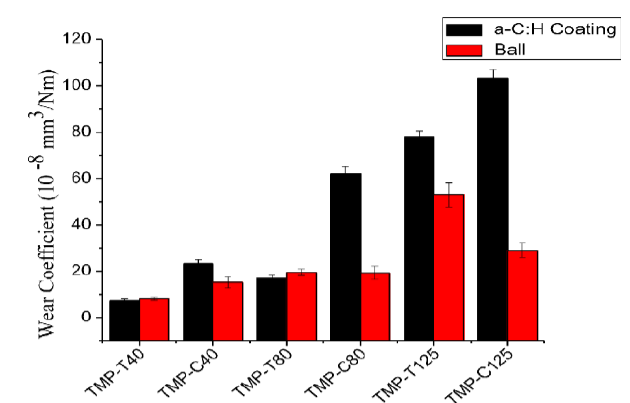
Figure 1. Wear coefficient of textured and un-textured DLC at various temperatures in TMP